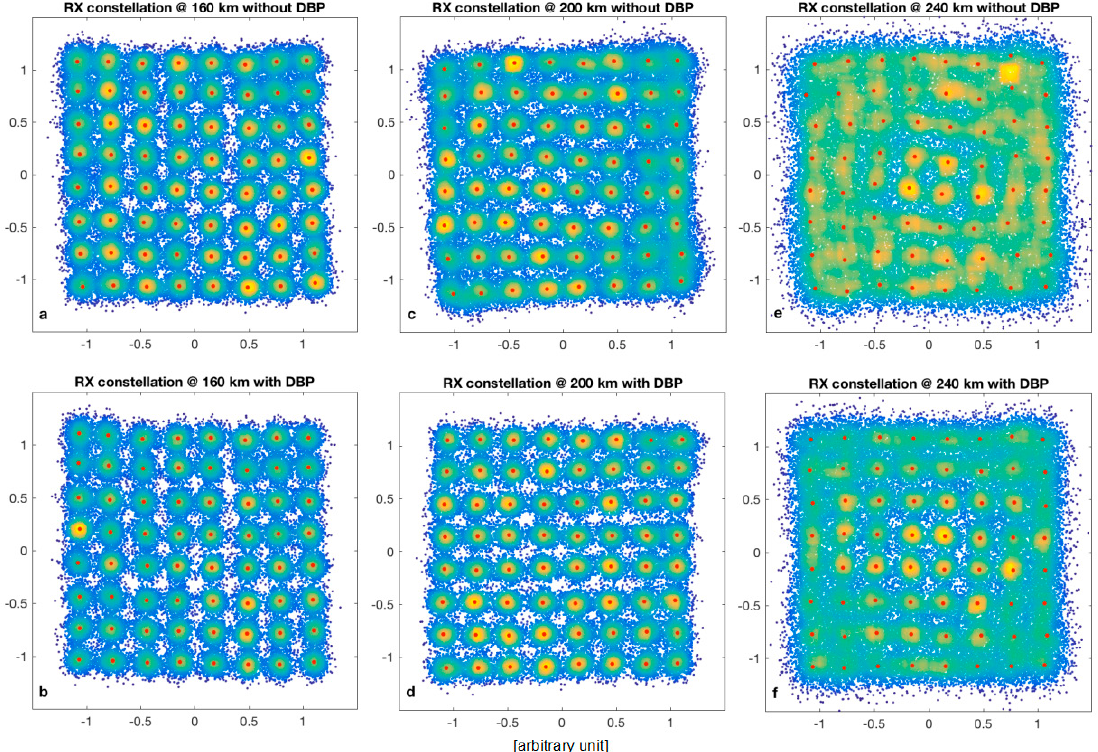
Figure 5. Constellation diagrams showing the best-case experimental result out of several configurations (see Figures 3 and 4) with (bottom) and without (top) applying DBP.